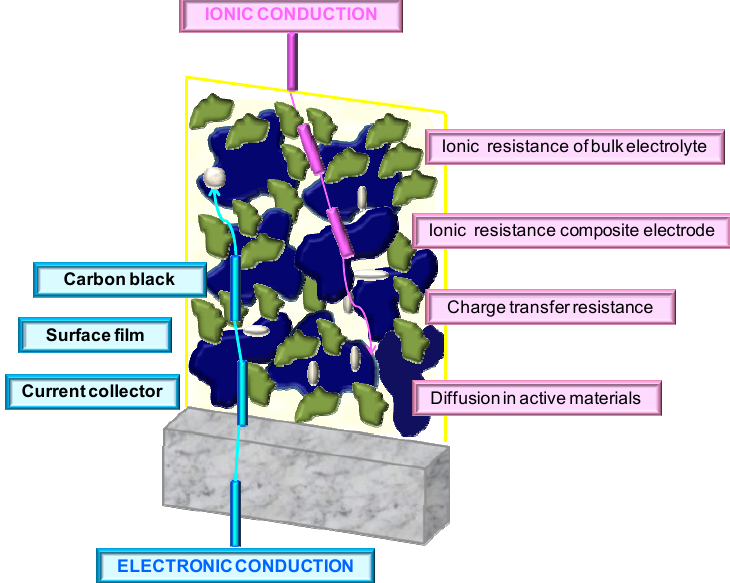
Scheme 1. Proposed of schematic illustration of composite electrode.